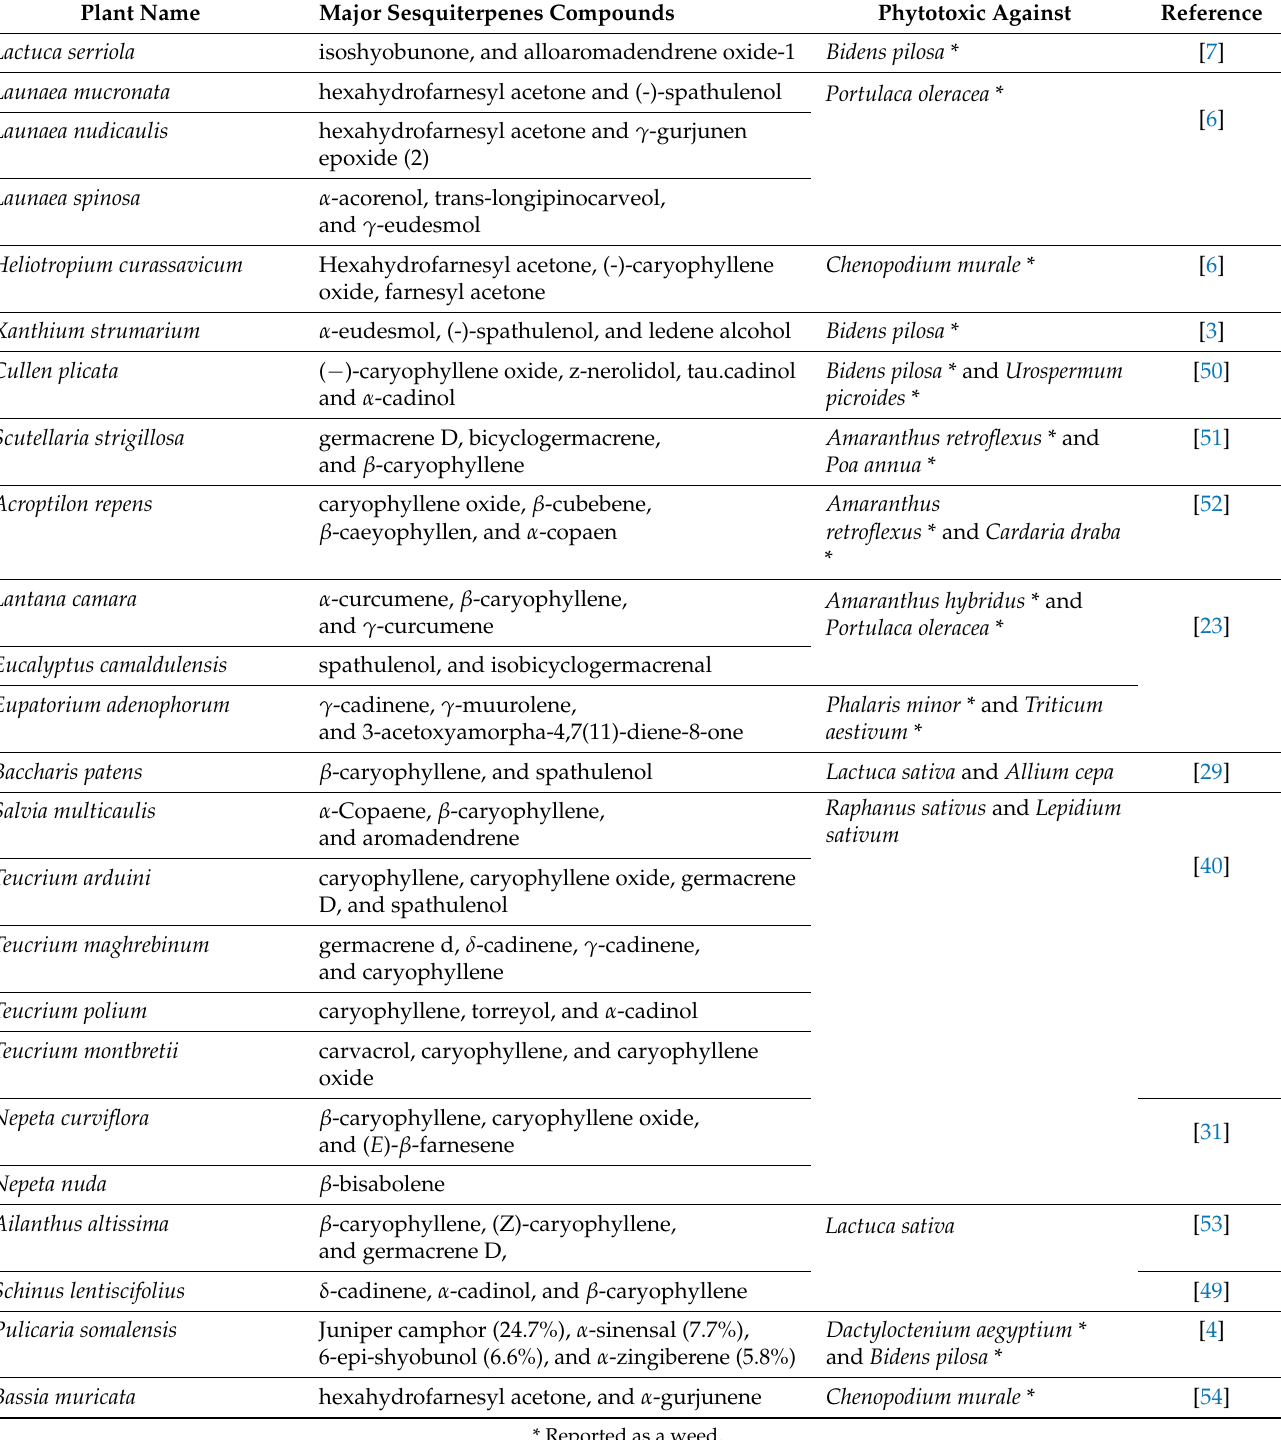
Table 2. Sesquiterpene-rich EOs derived from various plants and exhibiting phytotoxic